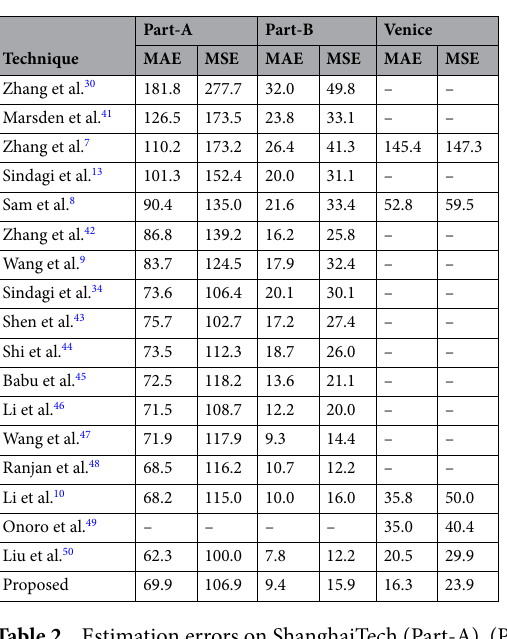
Table 2. Estimation errors on ShanghaiTech (Part-A), (Part-B), and Venice dataset.